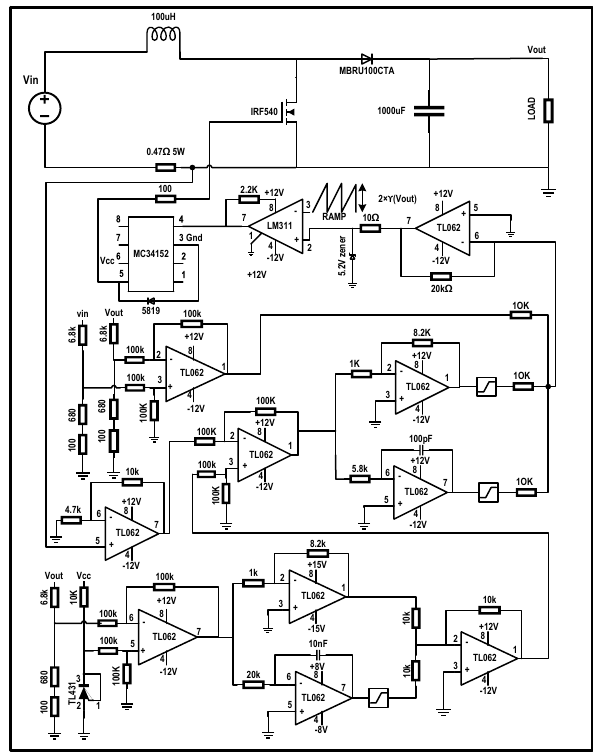
Figure 6. Schematic diagram of the proposed technique for voltage regulation in a single source using boost